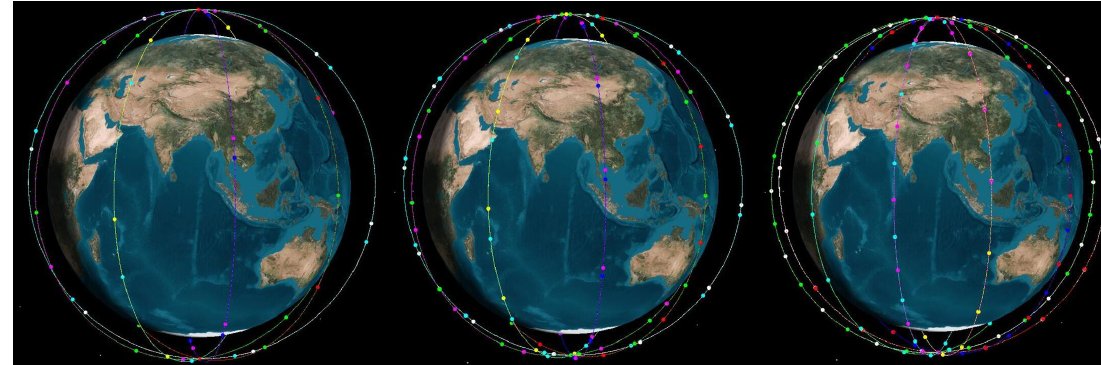
Figure 2. Configuration of 60-LEO ( left ), 120-LEO ( middle ), and 192-LEO ( right ) constellation.